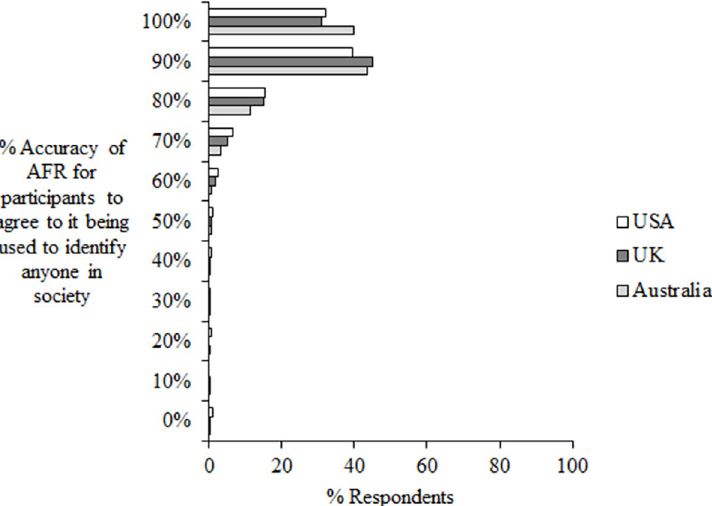
Fig 12. Question 19 data. Percent respondents choosing each percentage interval in response to question 19 “How accurate (in percentage) would this technology need to be in order for you to agree to it being used to identify anyone in society?”.